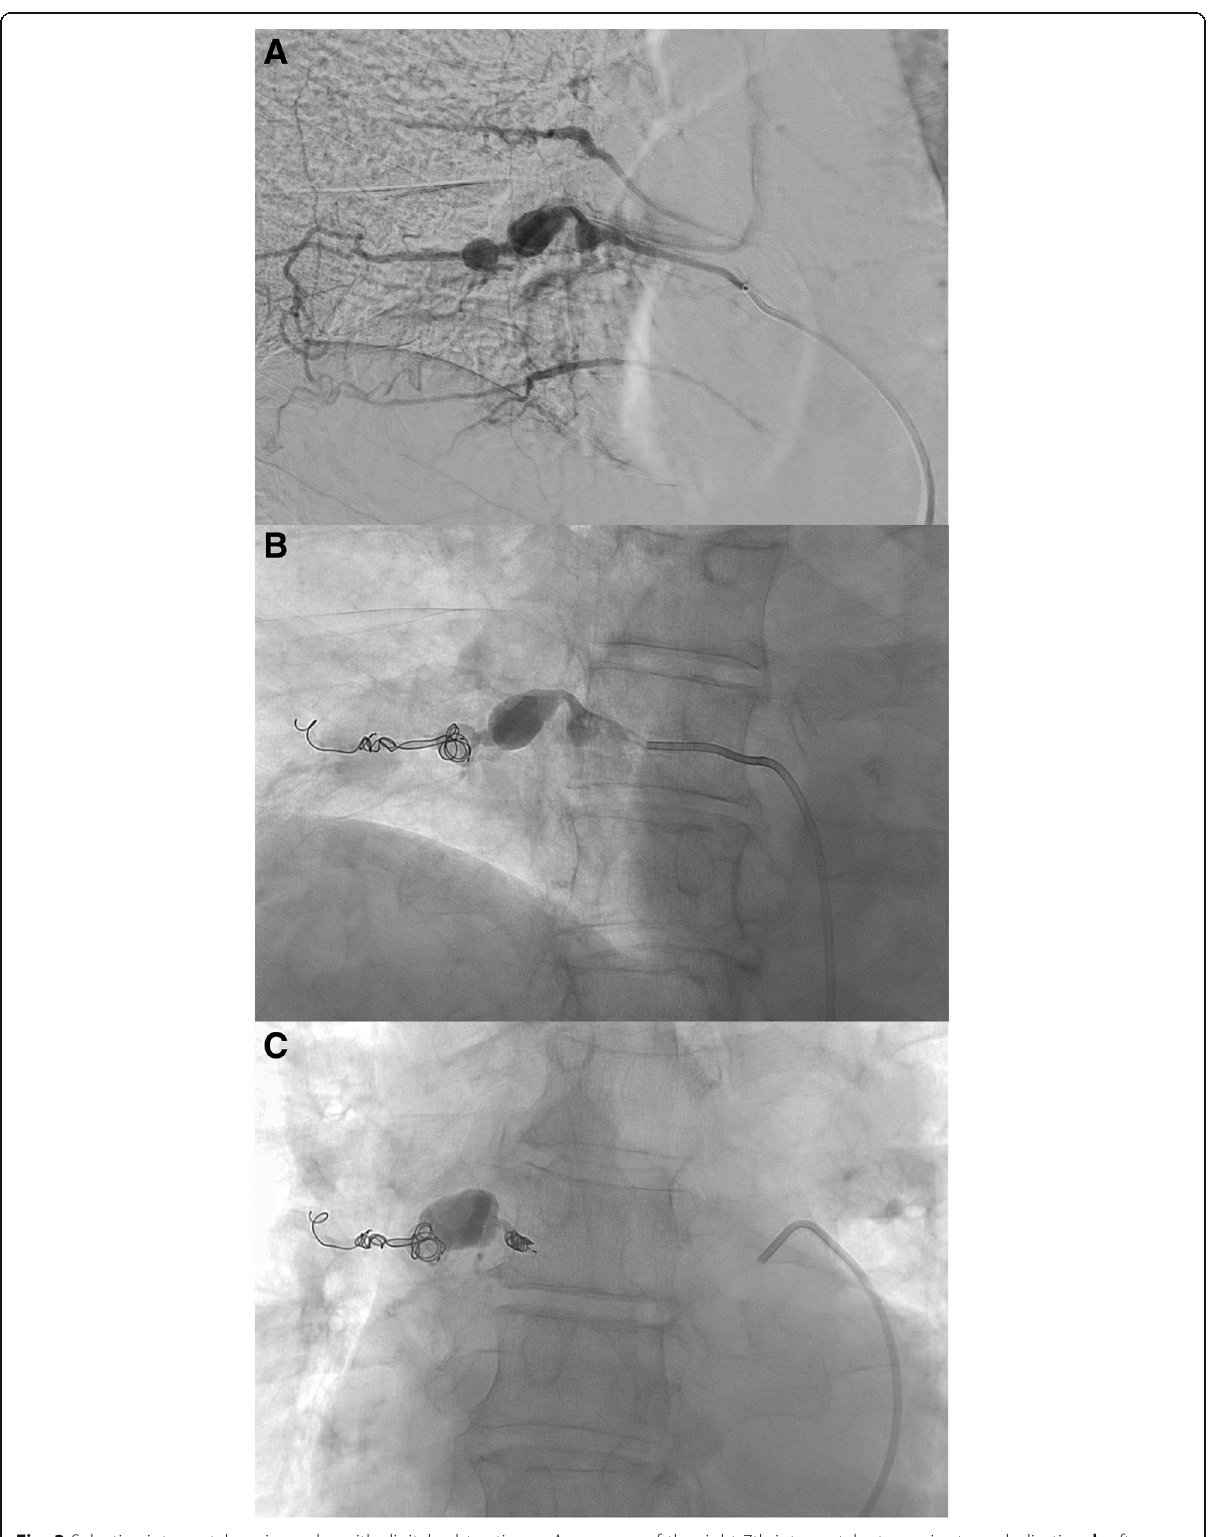
Fig. 3 Selective intercostal angiography with digital subtraction. a Aneurysms of the right 7th intercostal artery prior to embolization, b after distal occlusion with microcoils, and c following complete exclusion of the aneurysm sacs with microcoils and